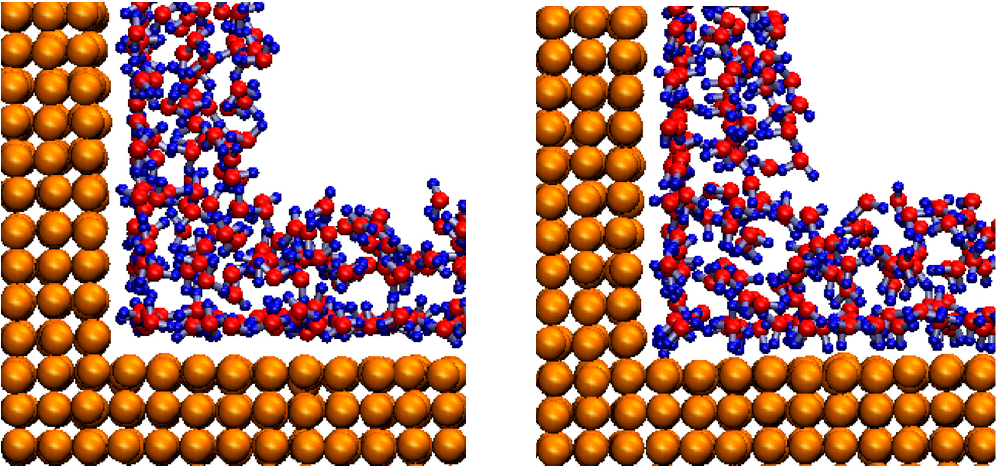
Figure 4. Snapshot of molecules close to the wall (only showing water molecules that are within 8 Å of copper wall atoms). Orange: copper atoms; red: oxygen atoms; blue: hydrogen atoms. Left: neutral wall; right: charged